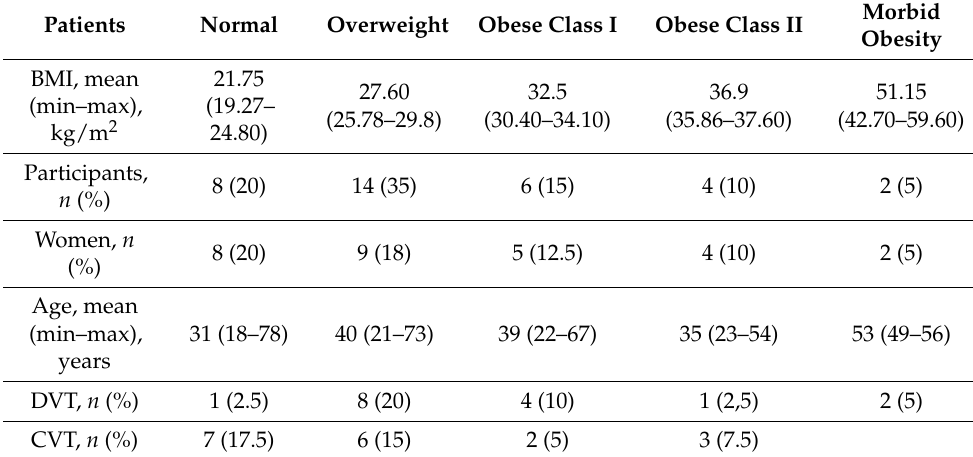
Table 2. Characteristics of patients in relation to